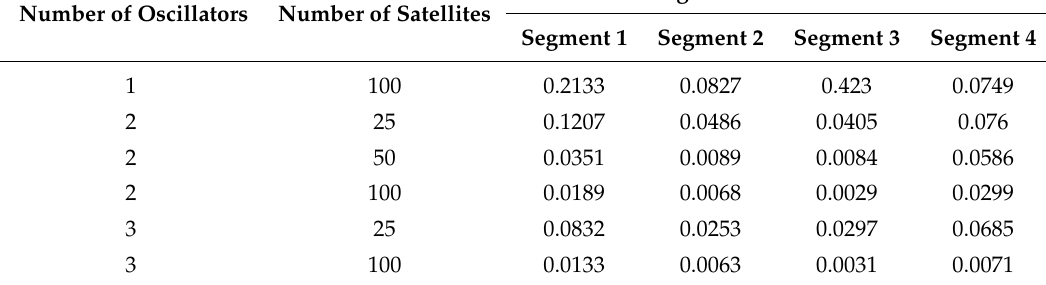
Table 1. Integral relative accuracies of approximations by centralized networks of CMU 86 Trial 1 using different numbers of oscillators and satellites. The motion was segmented into four segments at frames [ 1,1300,2000,3000,4500 ] . Integral Relative Accuracies Number of Oscillators Number of Satellites Segment 1 Segment 2